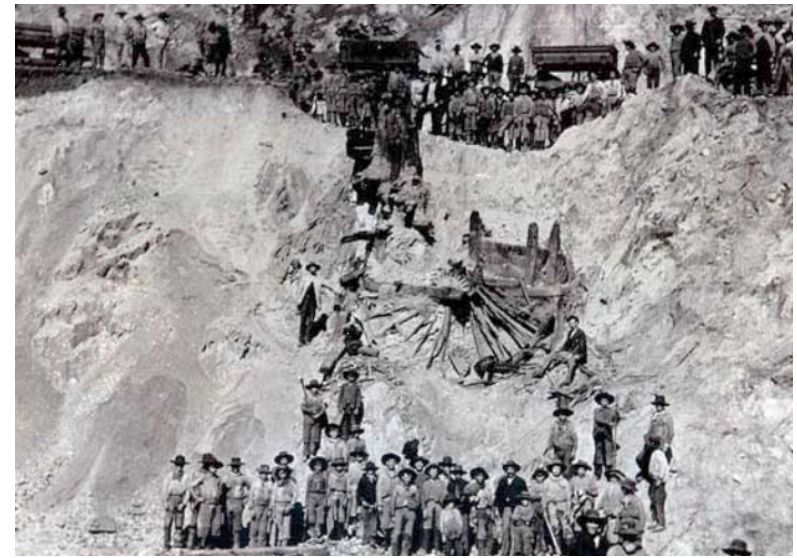
Figure 2. Roman wheel found in the early twentieth century in South Lode. It was part of